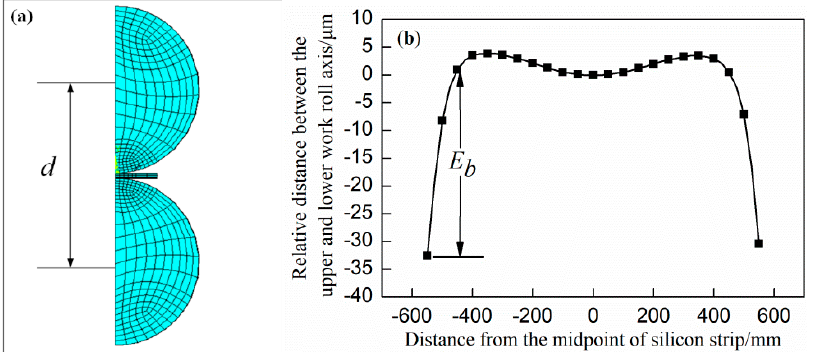
Figure 6. The edge drop for work roll bending: ( a ) Distance at any point between the upper and lower work roll axis; and ( b ) finite element calculation results.